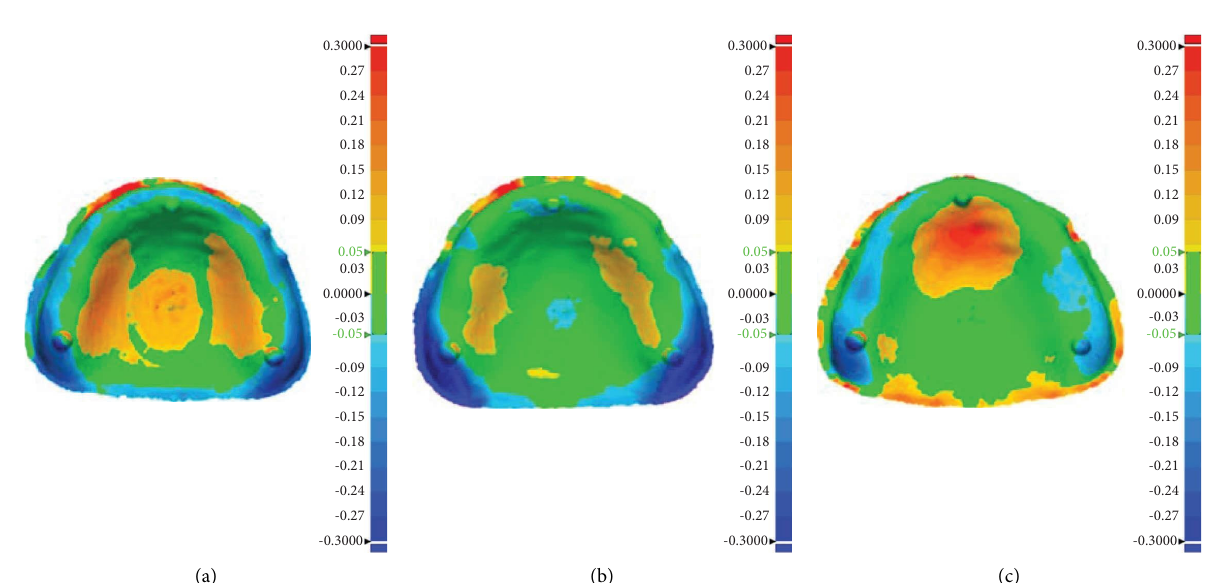
Figure 4: Te color mapping demonstrated deviation from reference model of denture bases printed with diferent build angle. (a) 0 ° . (b) 45 ° . (c) 90 °